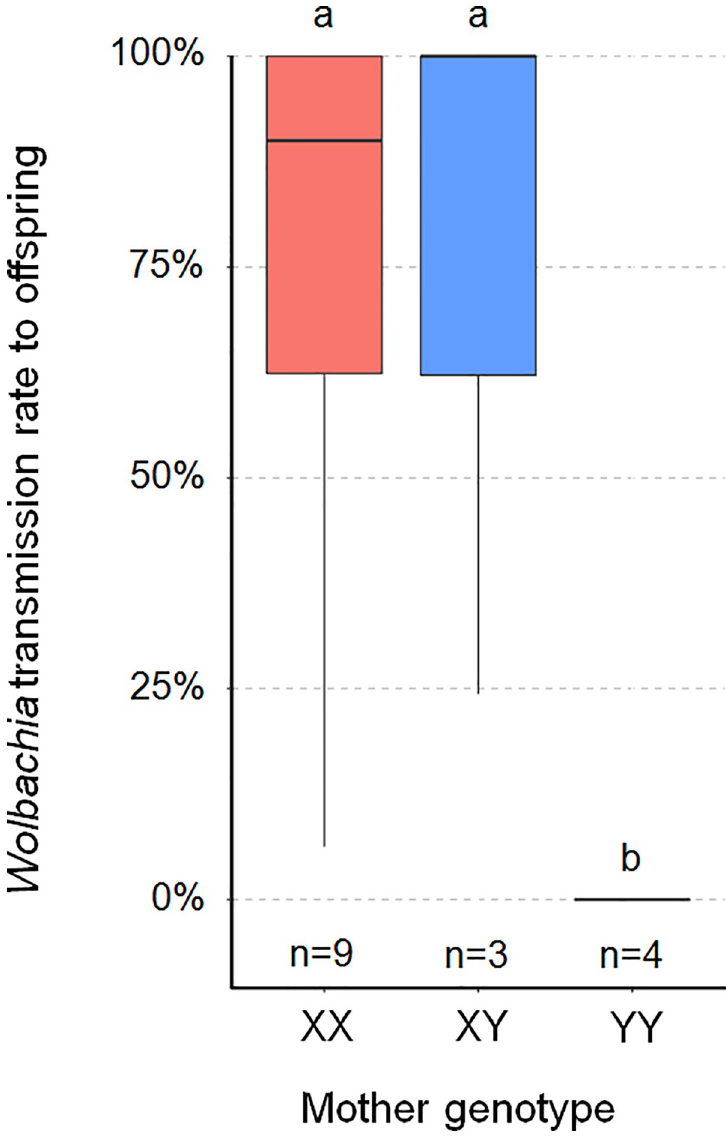
Fig 3. Boxplot of Wolbachia transmission rate from mother to offspring (measured as the frequency of Wolbachia -carrying individuals in each progeny) according to mother’s sex chromosome genotype. The analysis is based on 16 progenies (n), in which Wolbachia presence was tested in � 10 individuals (the underlying data for this figure can be found in Table 2). Thick lines and boxes depict median and interquartile range, respectively. Whiskers are bounded to the most extreme data point within the 1.5 interquartile range. Plots marked with the same letter (a, b) are not statistically different from each other (Kruskal-Wallis test followed by pairwise comparison Dunn test).